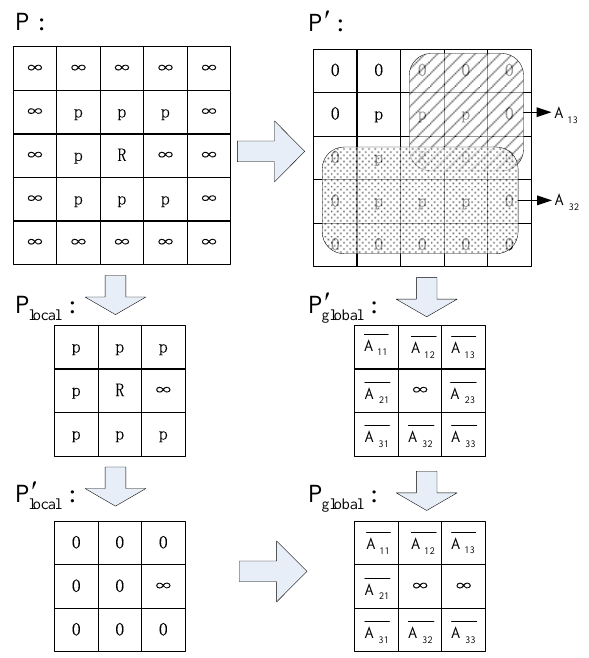
Figure 5. Steps of getting P global from P . R indicates the current position of the robot, and p is pheromone value that is not equal to ∞ . ∞ indicates the inaccessible cells. From P , we can get P (cid:48) and P local . P (cid:48) is compressed into P (cid:48) . P local transits to P (cid:48) by replacing all elements not equal to ∞ global local with 0. Finally, we get P global by summing up P (cid:48) and P (cid:48) . P global implies the average pheromone local global density at each direction and indicates the adjacent inaccessible cells with ∞